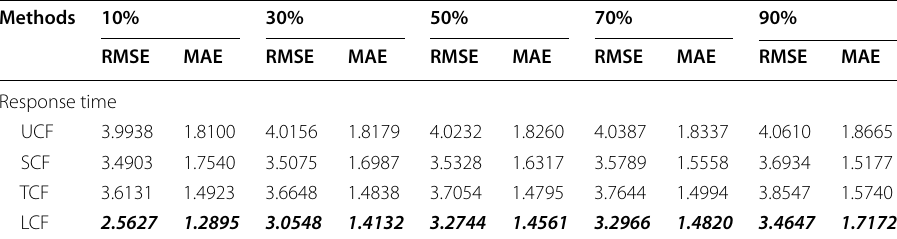
Table 1 Impact of data sparsity on prediction